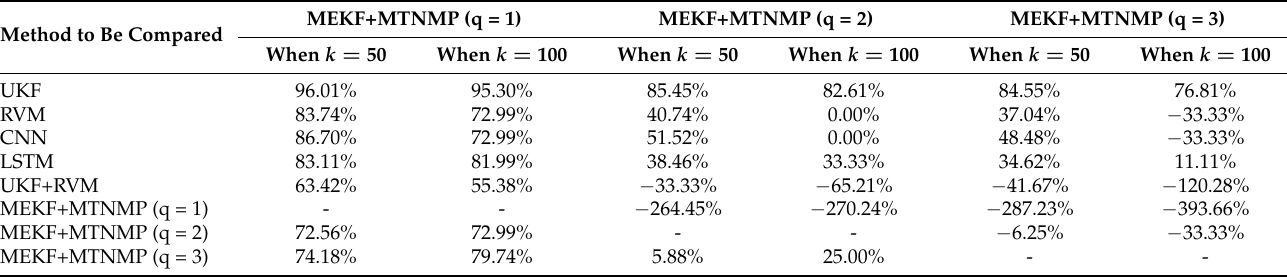
Table 5. Comparison of methods in the B0006 experiment.